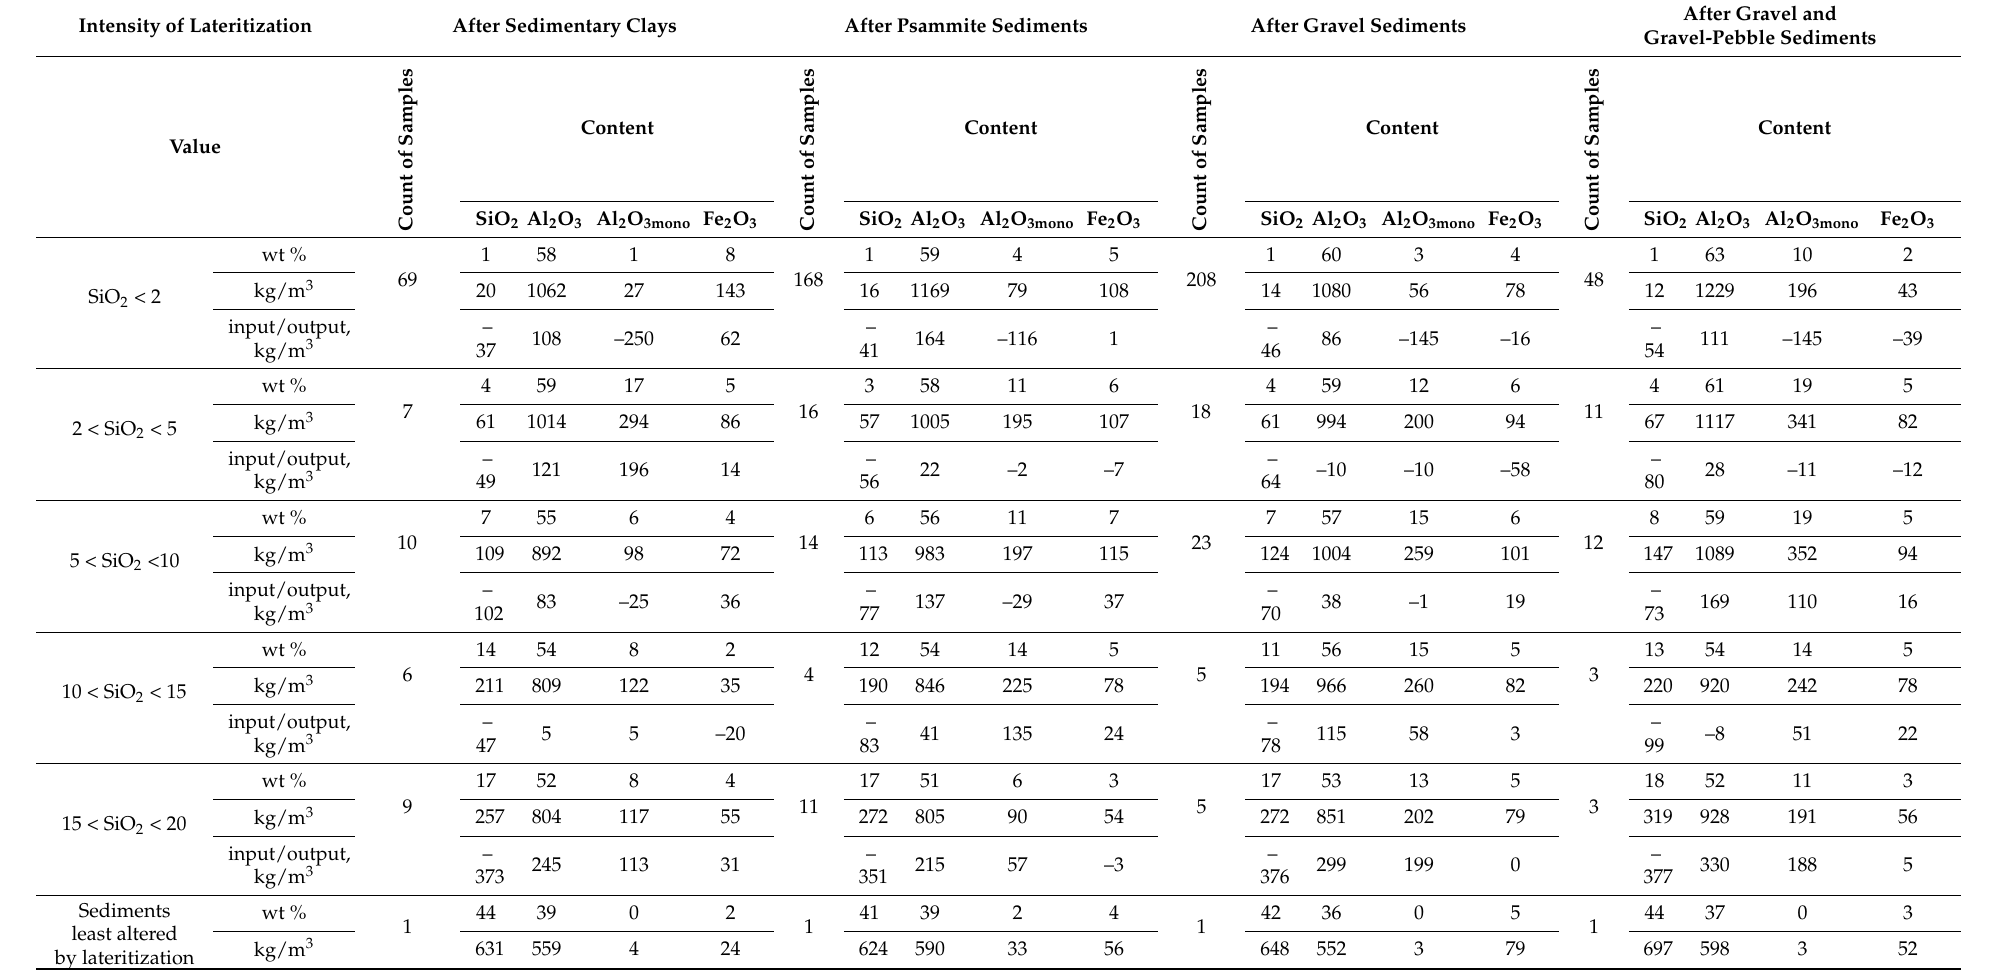
Table 2. The composition of sedimentary-lateritic formations of the Sangaredi Group with consideration of their lithological facies and intensity of lateritic weathering. Note: input/output values are calculated in relation to subjacent rocks of the weathering profile that are less lateritized. Intensity of Lateritization After Sedimentary